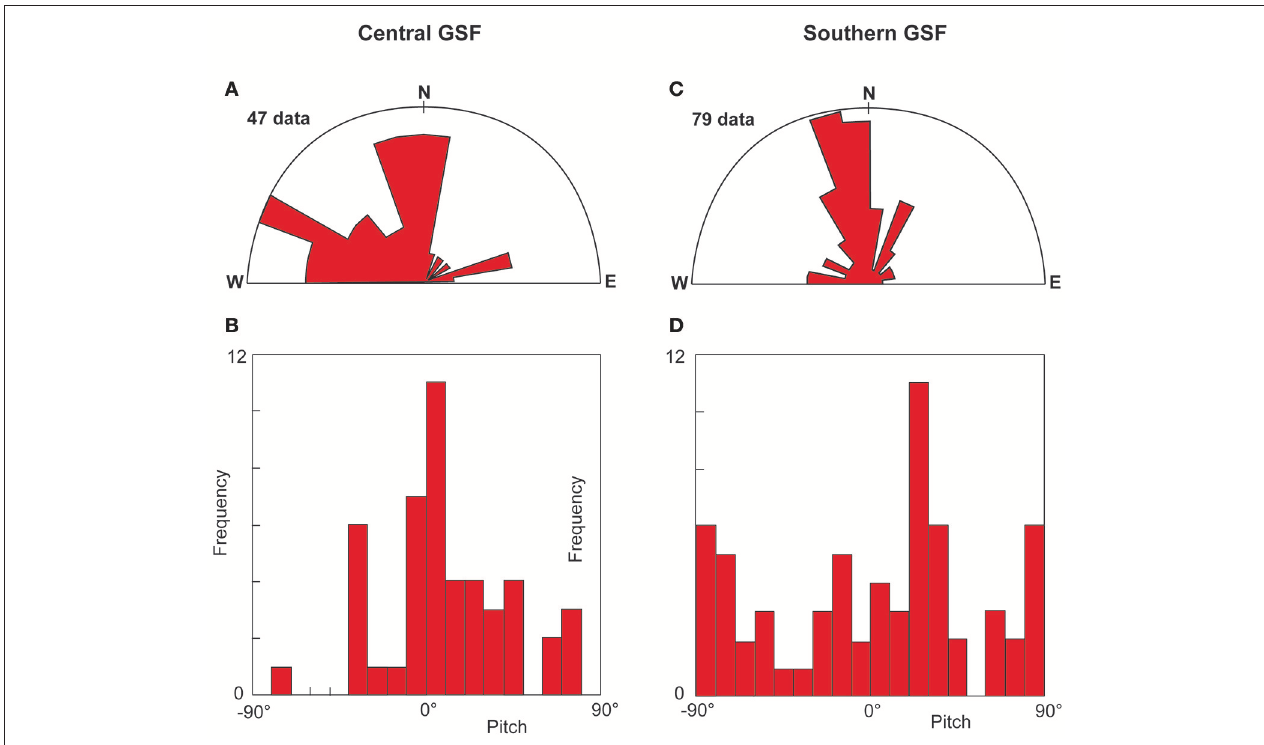
FIGURE 11 | Distribution of the strike (A) and pitch (B) of the collected faults shown in Figure 7 (central GSF; A,B ) and in Figure 8 (southern GSF; C,D ). Here we use the convention that pitch values range from − 90 ◦ to + 90 ◦ ; these correspond to pure strike-slip motions, whereas pitches = 0 ◦ correspond to pure dip-slip motions.